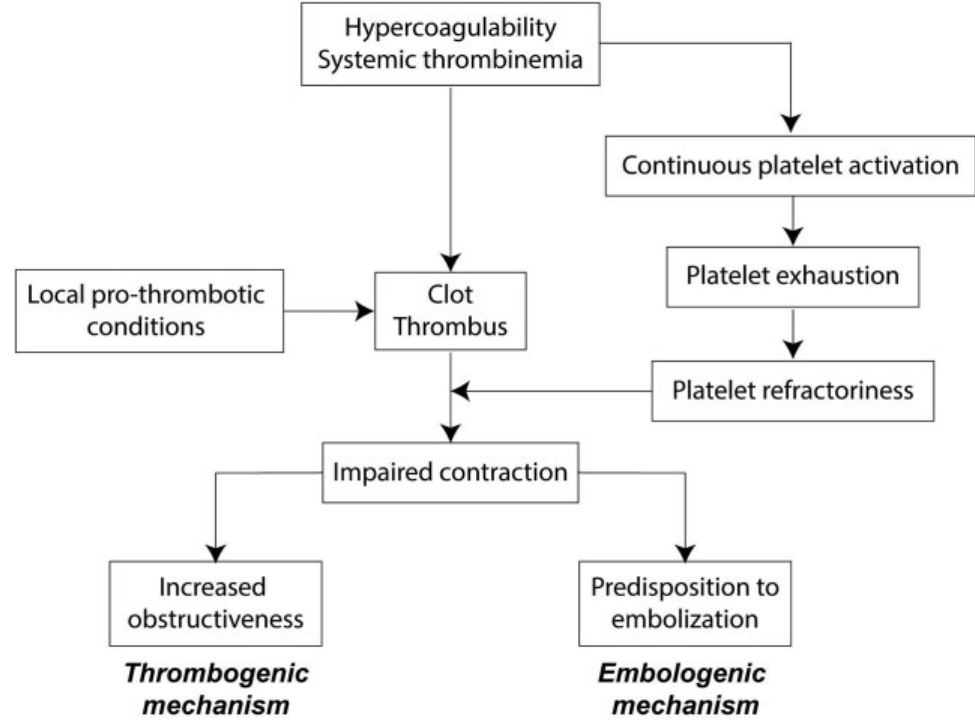
Fig. 6 Proposed pathogenic mechanisms related to the impaired clot contraction in venous